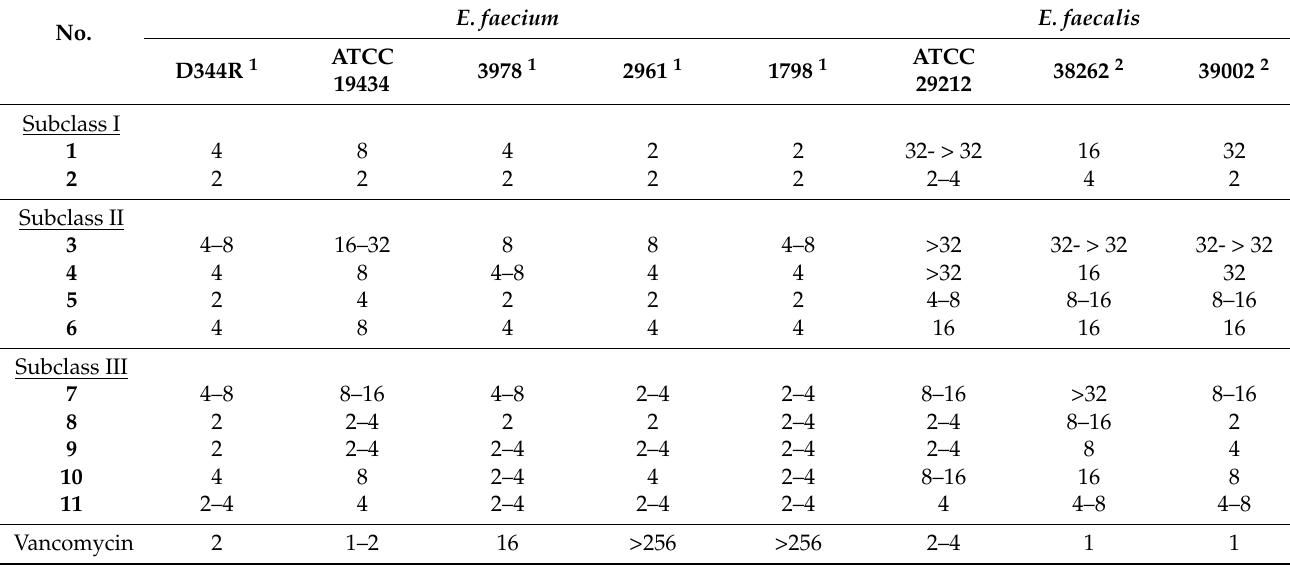
1 E. faecium D344R, 3978, 2961 and 1798: human clinical isolates; 2 E. faecalis 38262 and 39002: veterinary isolates.